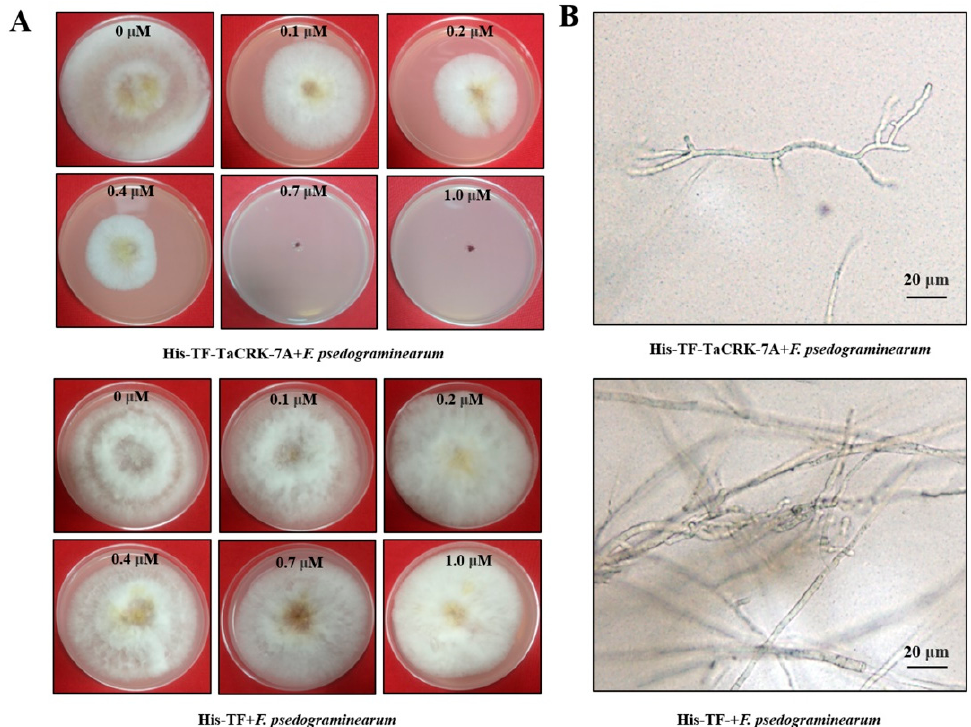
Figure 1. Assay on inhibition of the purified TaCRK ‐ 7A protein against F. pseudograminearum hyphae growth. ( A ) The growth status of liquid F. pseudograminearum mycelia on the PDA medium plus His ‐ TF ‐ TaCRK ‐ 7A protein or plus His ‐ TF (control) at different concentration (0, 0.1, 0.2, 0.4, 0.7, and 1 μ M) on the fifth day. ( B ) Light microscopic photos on the hyphae of F. pseudograminearum after being treated by His ‐ TF ‐ TaCRK ‐ 7A or His ‐ TF (control). Scale bars = 20 μ m.